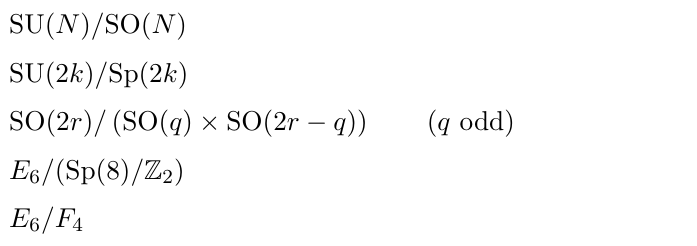
Figure 5 . The Dynkin diagram E 6 has a Z 2 outer automorphism which interchanges its two branches. Folding it by average yields its C -invariant subalgebra F